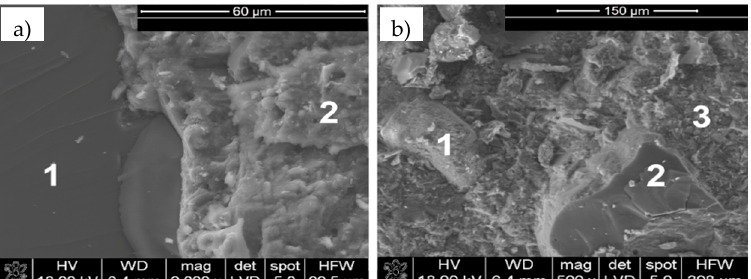
Figure 1. Microstructure of the RPC after 28 days of maturation with a visible C–S–H phase closely adhered to the quartz particles. ( a ) C–S–H phase (point 2) and quartz particle (point 1). ( b ) C–S–H phase (points 1 and 3) and quartz particle (point 2).